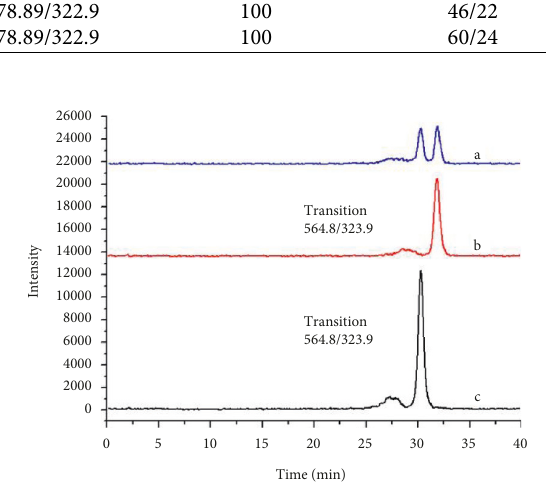
Figure 1: Liquid chromatography-tandem mass spectrometry chromatogram of standards. (a) Mix of UDP-galactose and UDP- glucose. (b) UDP-galactose. (c)